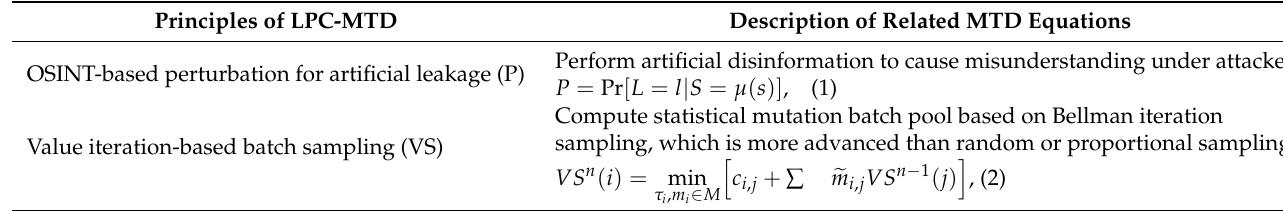
Table 2. Definition of MTD principles and major equations for configuration of LPC-MTD. Principles of LPC-MTD Description of Related MTD Equations